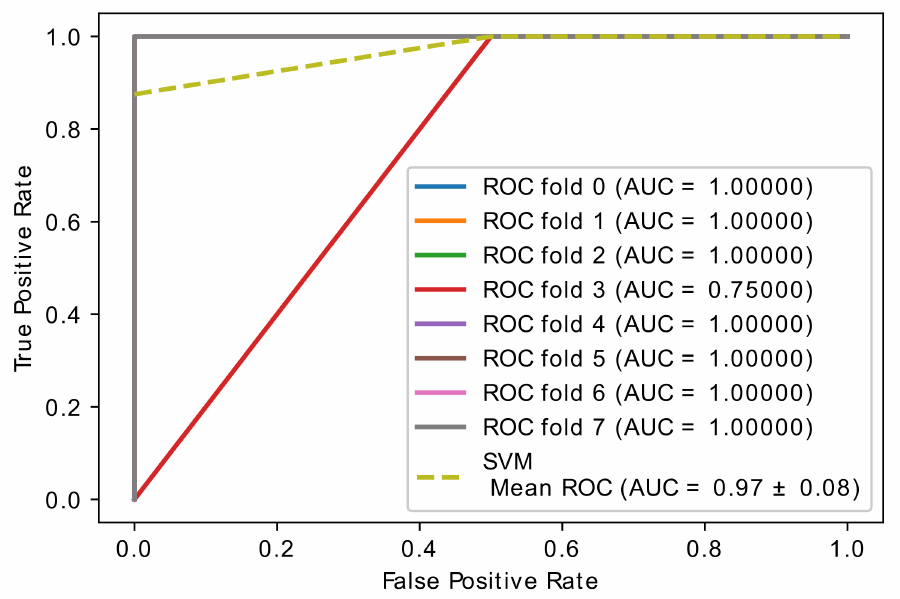
Figure 9. Accuracy curve of SVM